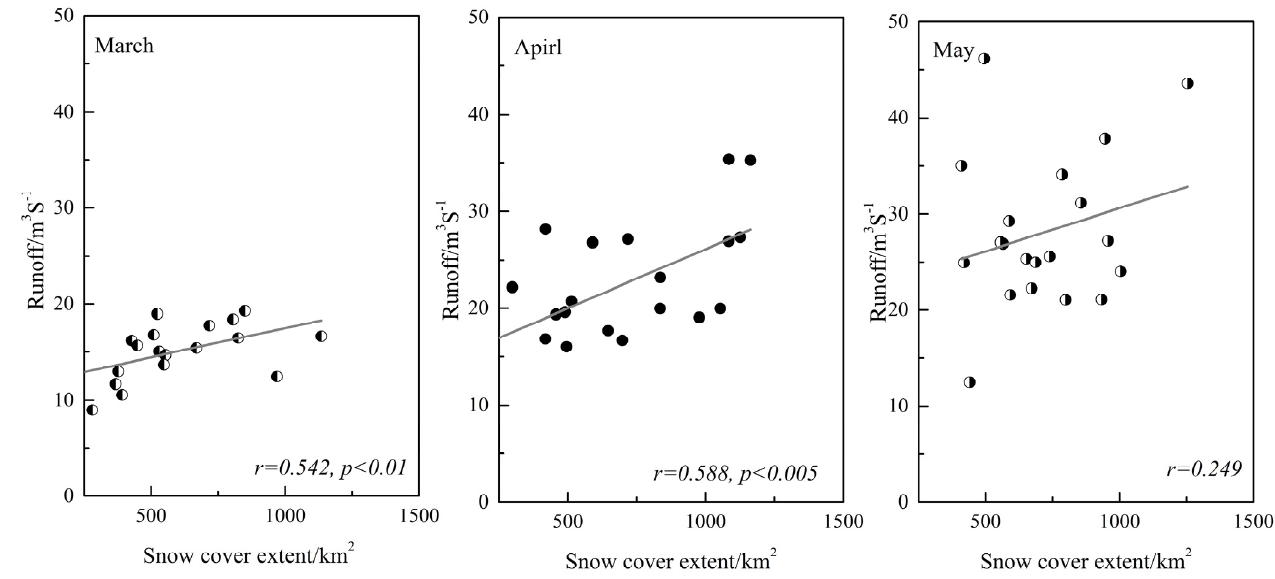
Figure 5. Correlation between snow cover extent and runoff at the monthly scale.